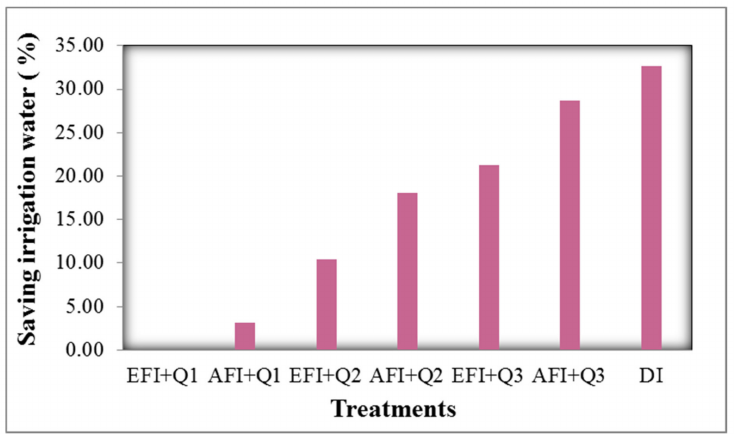
Figure 6. Effect of irrigation method (EF, AF, and DI) and flow rate (0.47 (Q1), 0.95 (Q2), and 1.43 L/s (Q3)) on irrigation-water-saving percentage across two